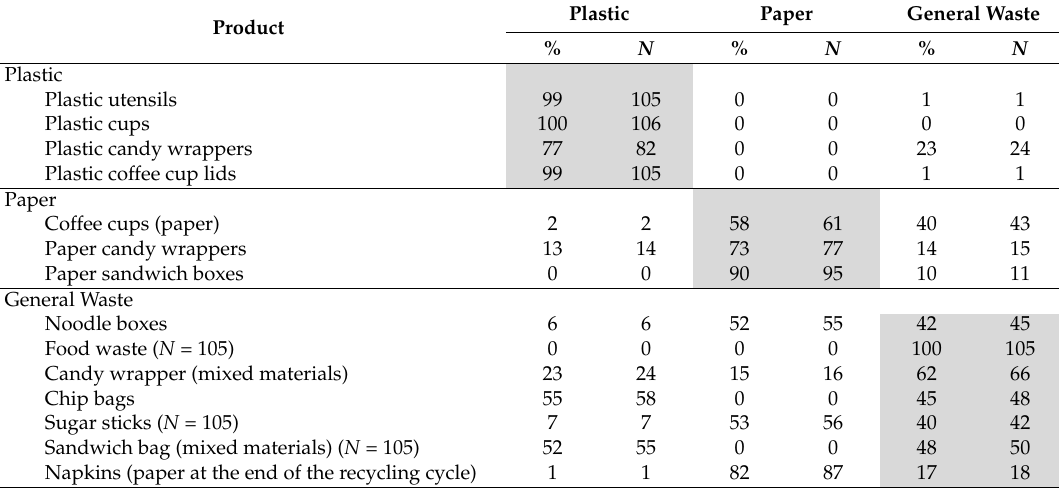
Colorized: the percentage and number of correct sortings.